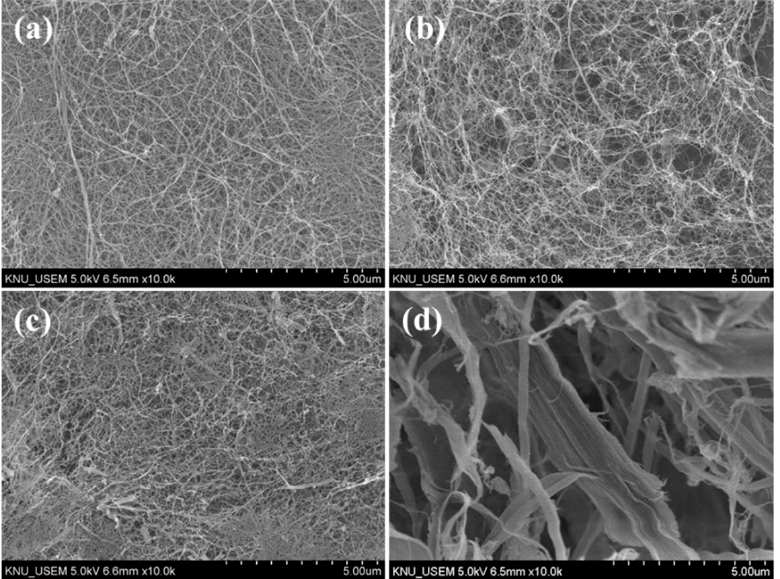
Figure 1. SEM images of PCNF ( a ), LCNF5 ( b ), LCNF19 ( c ), and LCNF30 ( d ).